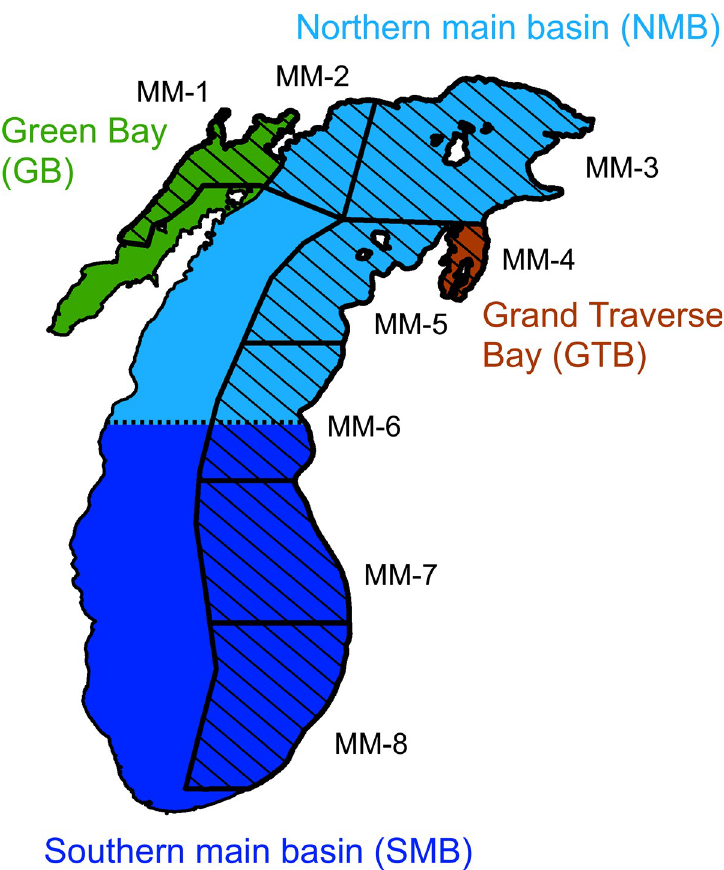
Fig 3. The four Lake Michigan regions defined in this study and the State of Michigan’s (fishery) statistical districts (MM-1–MM-8). The four regions, including Green Bay, Grand Traverse Bay, northern main basin, southern main basin, are marked in different colors and the State of Michigan’s fishery statistical districts are cross-hatched. The map was generated by using a geographic information system (GIS) software ArcGIS version 10.4